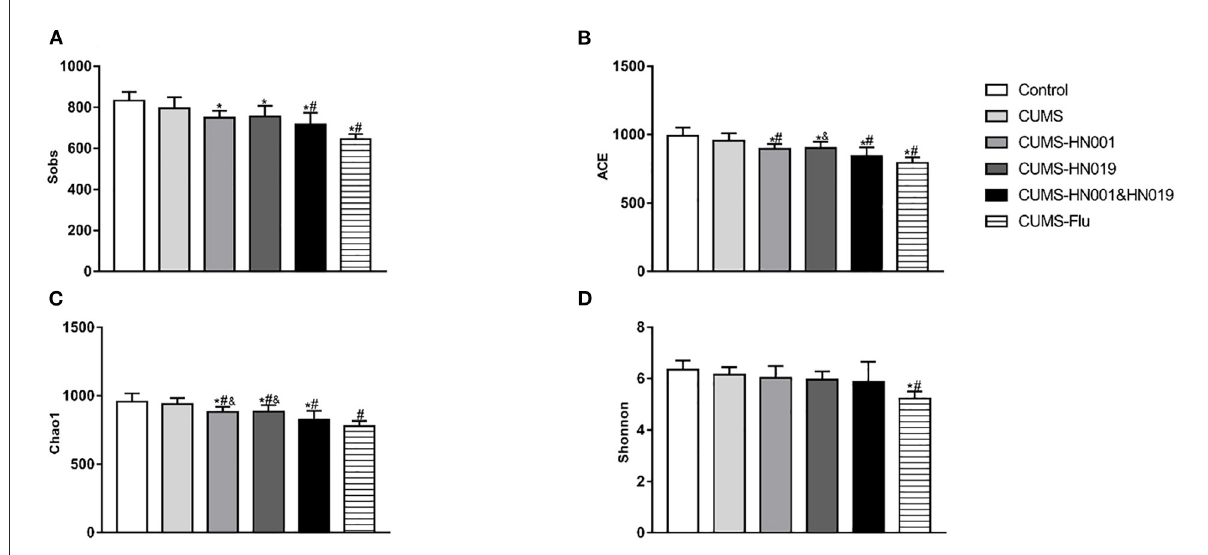
FIGURE7 Effects of probiotics treatment on gut microbiota changes induced by CUMS. (A) Sobs index, (B) ACE index, (C) chao1 index, (D) Shonnnon index. The results were presented as the Mean ± SEM ( n = 7). * p < 0.05 compared with control group. # p < 0.05 compared with CUMS group, & p < 0.05 compared with CUMS-HN001&HN019